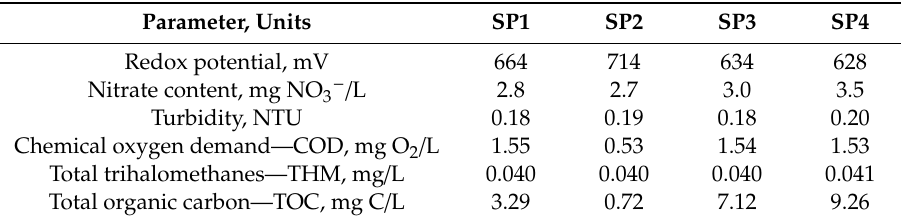
Table 2. The overall quality of swimming pool water determined by the additional